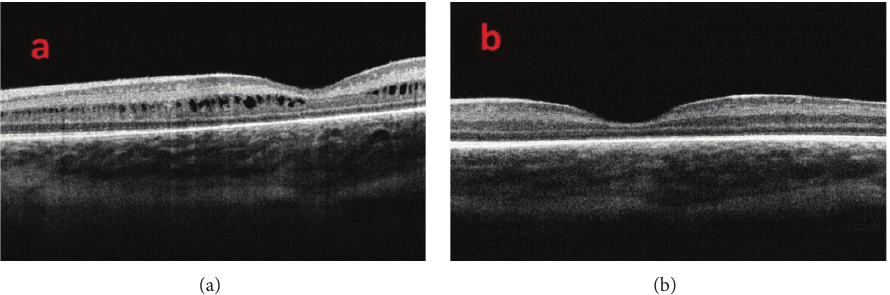
Figure 4: (a) OCT image of a patient with cystoid macular edema at 39-week postmenstrual age and (b) after resolution of cystoid macular edema six weeks later.